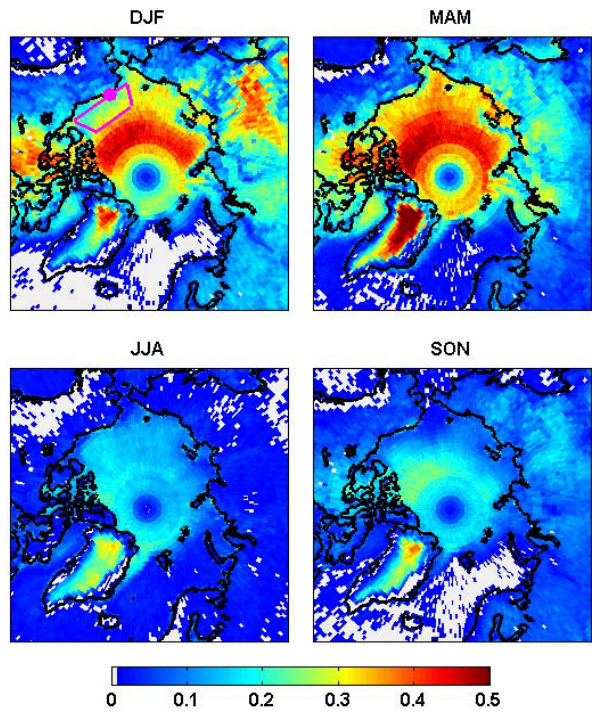
Fig. 1. Fraction of clear-sky observations available for analysis dur- ing the 2002–2010 period. The small circle and trapezoid in ma- genta colour denote the locations of Barrow station and SHEBA area,